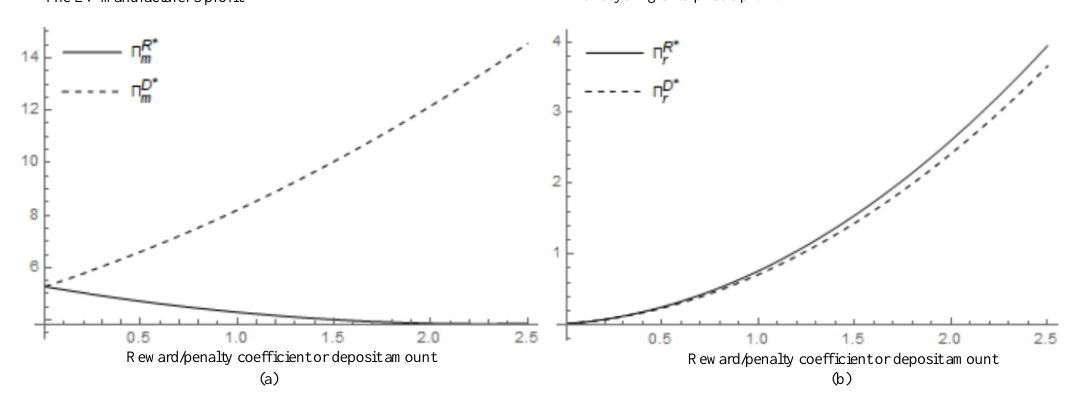
Figure 5. The effect of reward/penalty coefficient or deposit amount on the profits of the EV